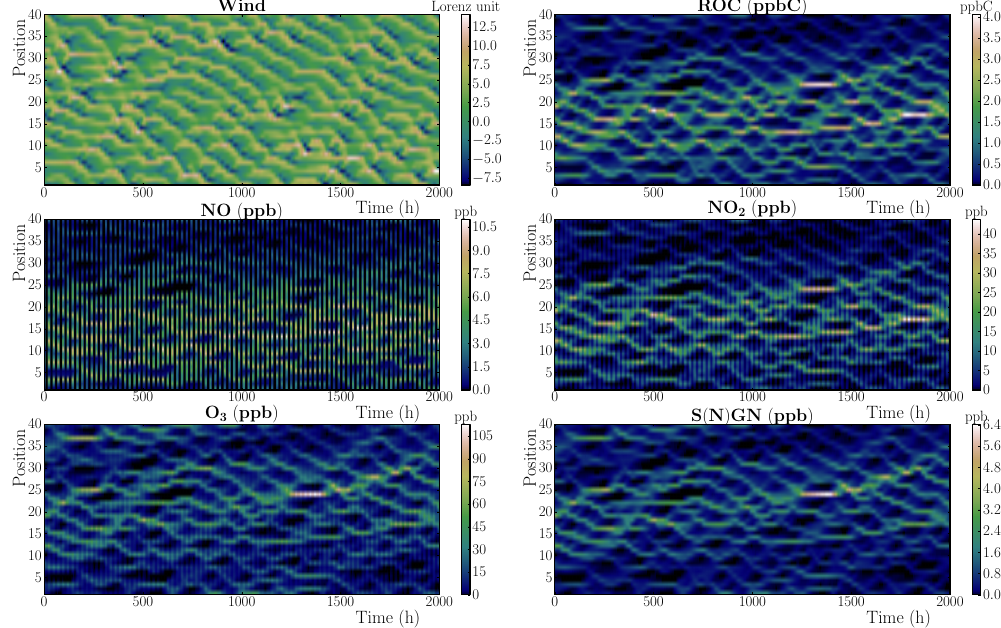
Figure 3. Time evolution of the L95-GRS variables over the whole domain in the case of a continent/ocean division. The L95 variables, flagged “Wind”, are shown with the original Lorenz unit, while the concentration unit is ppb (ppbC for